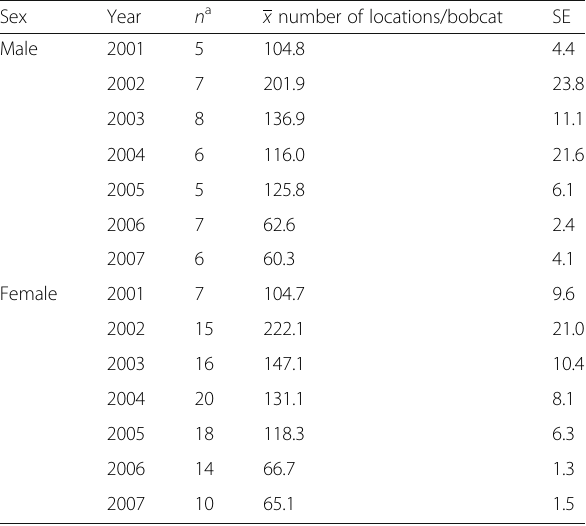
Table 1 Mean number (and SE) of radio-telemetry